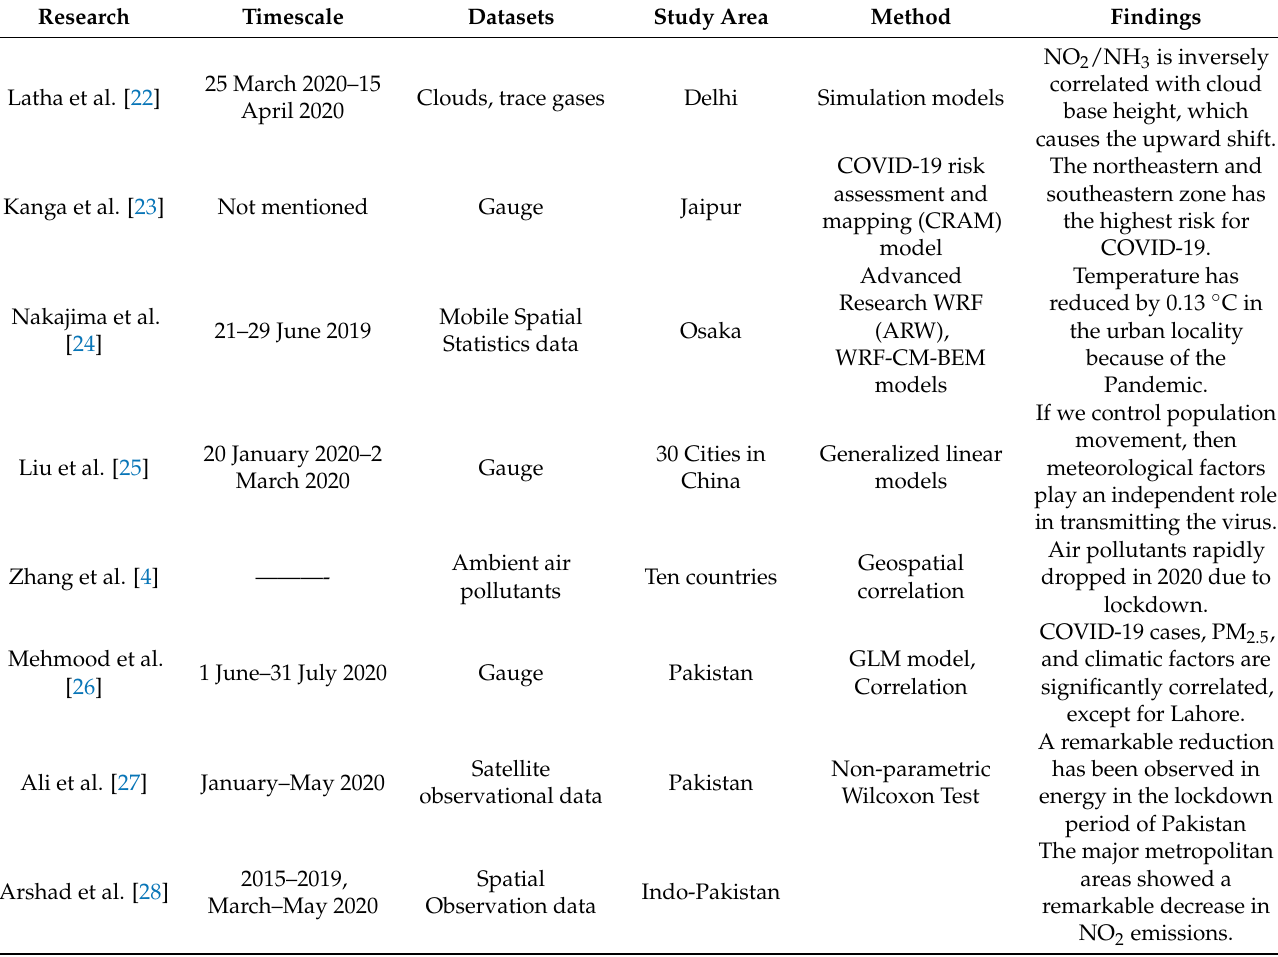
Table 1. An outline summary of the previous studies on COVID-19 and climate of